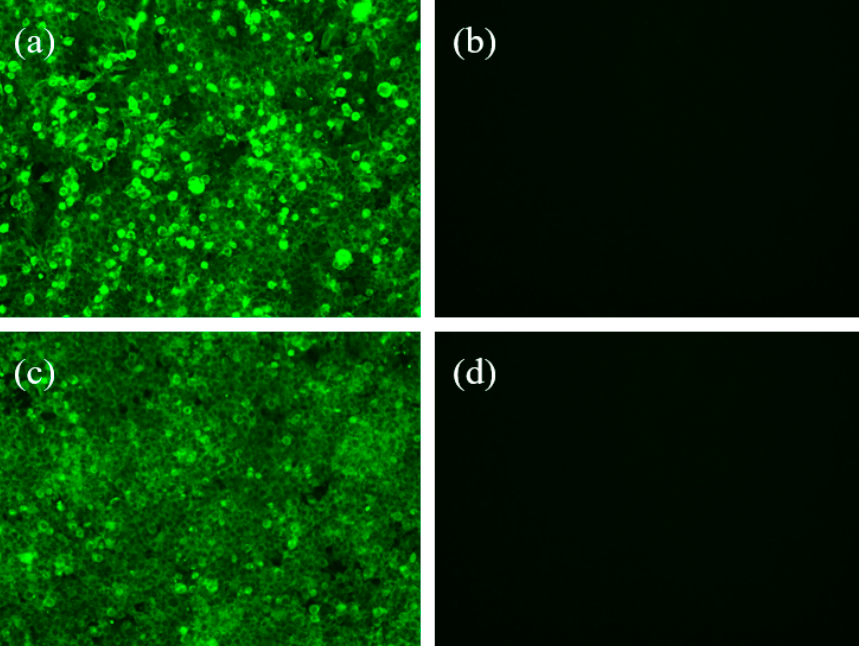
Figure 3. Identification of recombinant viruses rSRV9-H and rSRV9-F by indirect immunofluores- cence. The viruses were labeled with rabbit anti-PPRV H and PPRV F polyclonal antibody serum and an FITC-labeled goat anti-rabbit IgG antibody and observed under a fluorescence microscope. ( a ) Recombinant virus rSRV9-H, ( b ) negative control, ( c ) recombinant virus rSRV9-F, ( d ) negative control.